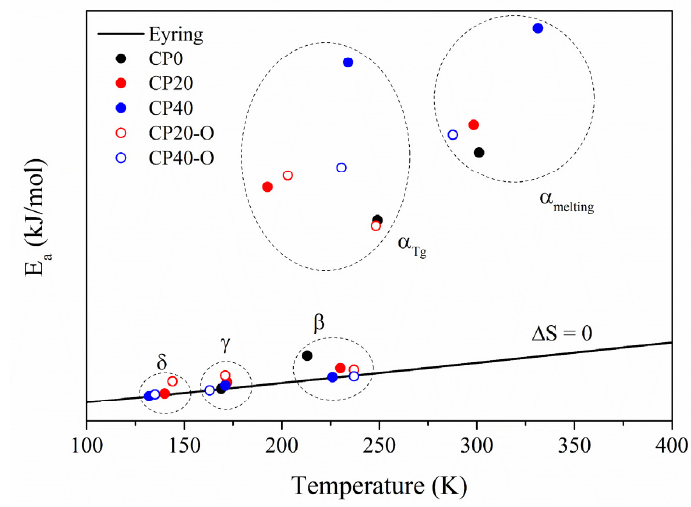
combination with the thermal orientation process seems to favour the dynamics of the γ relaxation. Figure 8. Eyring graph for all the dielectric relaxations of the neat and modified copolymers.